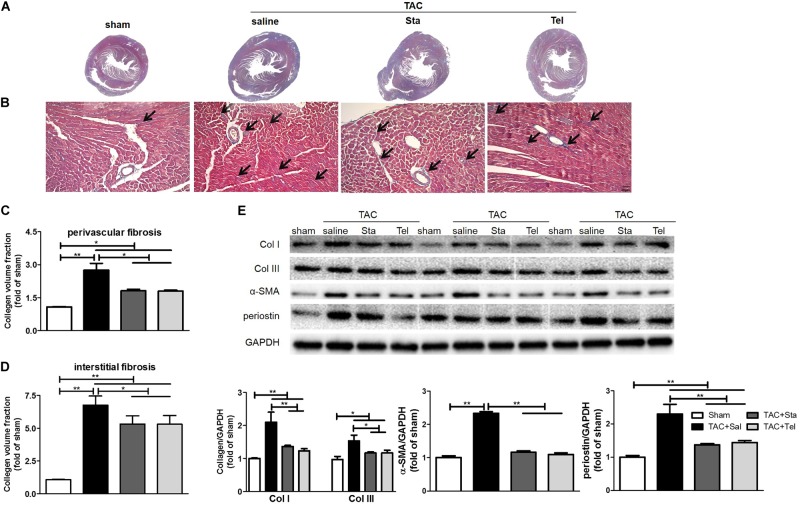
Sta suppressed myocardial fibrosis induced by pressure overload. (A) Representative slides of cardiac cross sections by Masson’s trichrome. (B) Representative histology of cardiac interstitial fibrosis by Masson’s trichrome staining (magnification ×100). The cardiomyocytes were stained for red, and collagenous fibers were blue. Scale bar: 20 μm. (C,D) Quantification of cardiac perivascular and interstitial fibrosis. (E) Representative western blots (upper panel) and quantification (lower panel) of myocardial Col I and III, α-SMA, periostin, and GAPDH. Collagen deposition was quantitatively analyzed via collagen volume fraction, which equals collagen area/total area × 100%. At least five to six slides per animal in each group were measured by Image-Pro Plus. The data were expressed as the mean ± SEM. ∗∗P < 0.01; ∗P < 0.05; n = 3–4 in each group; TAC, transverse aortic constriction; Sal, saline; Sta, stachydrine; Tel, telmisartan; Col I and III, collagen I and III; α-SMA, α-smooth muscle actin; GAPDH, glyceraldehyde-3-phosphate dehydrogenase.